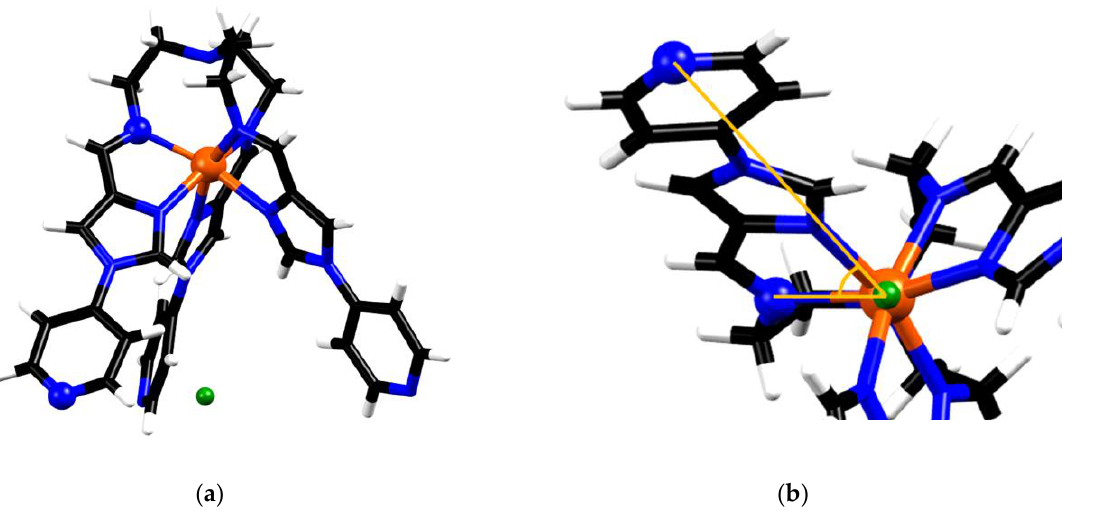
Figure 7. Schematic showing the torsion angles used to represent molecular twist, ( a ) highlights the chosen atoms (represented by balls) and the centroid between distal N’s (green) ( b ) shows the torsion angle, as viewed along the pseudo threefold axis of the metalloligand in FeL 2+ .